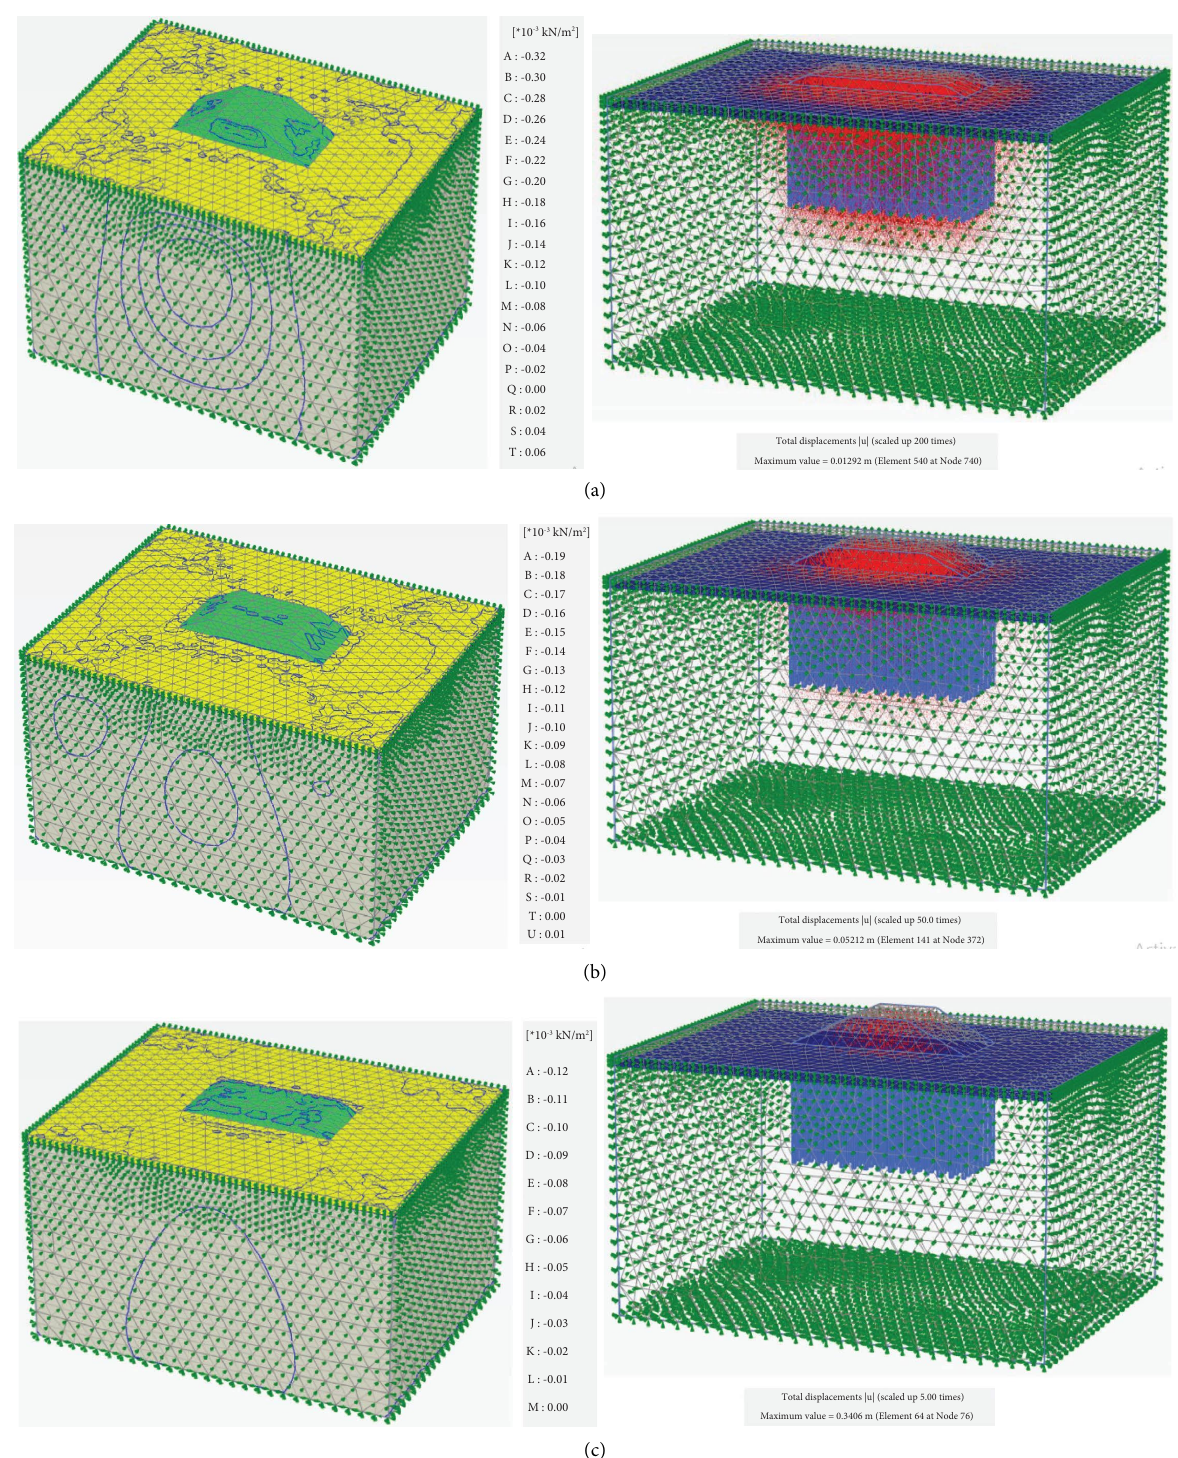
Figure 7: Mesh geometry indicating PWP and settlement variation: (a) the 1 st round fll, (b) the 2 nd round fll, and (c) the 3 rd round